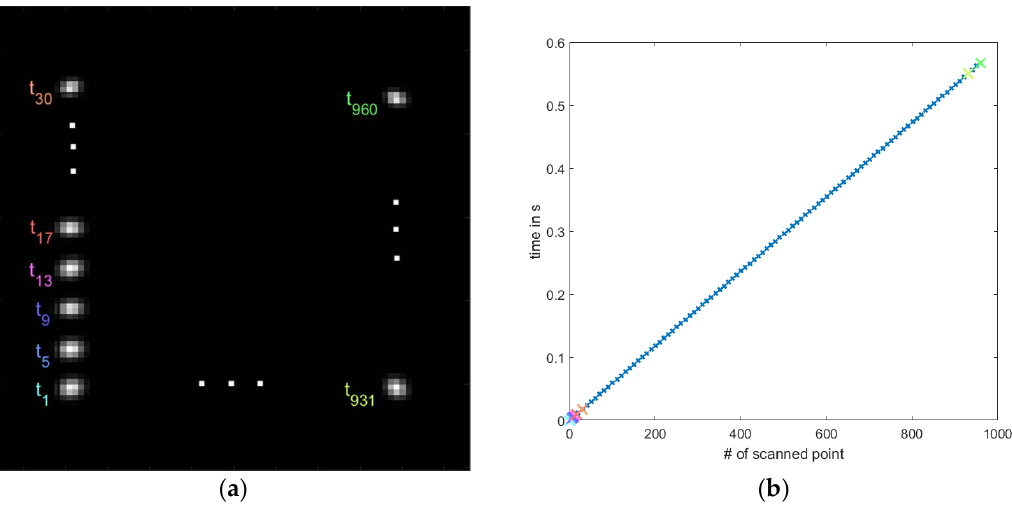
Figure 6 . Raster scan of an area of (1.5 × 1.5) µm at 961 positions. The raster positions are indicated in ( a ). The time taken to scan the positions is depicted in ( b ). The overall scan takes 0.568 s, which results in a framerate of 1.7 kHz or a temporal resolution of 0.59 ms.